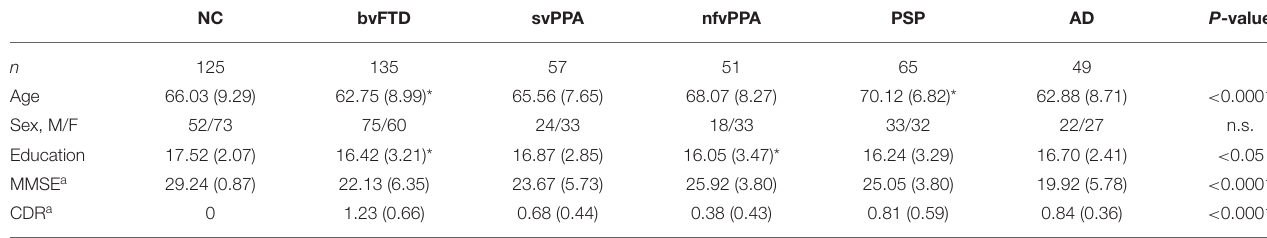
TABLE 1 | Demographic and clinical characteristics of patient